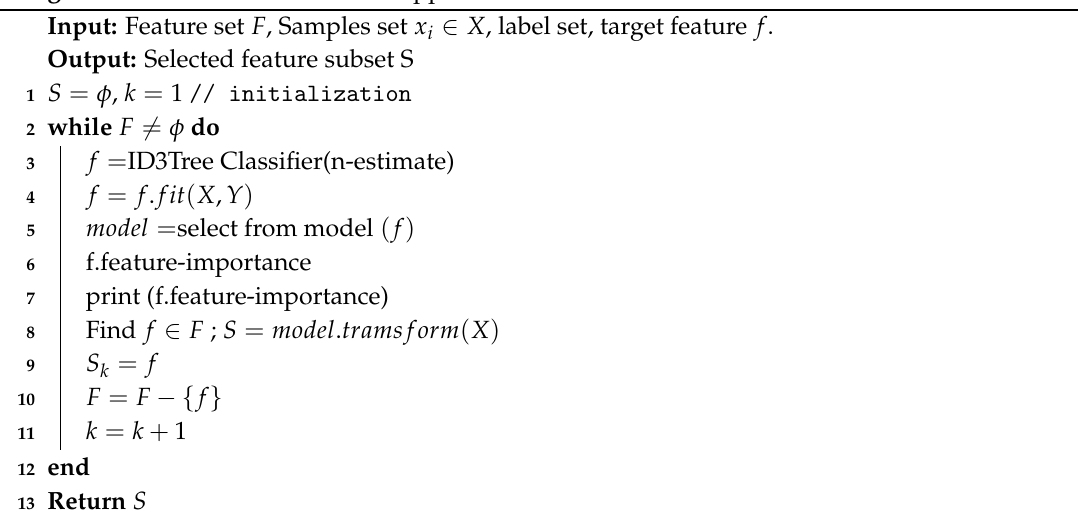
Algorithm 1: Filter Based DT-ID3 Approach for Feature